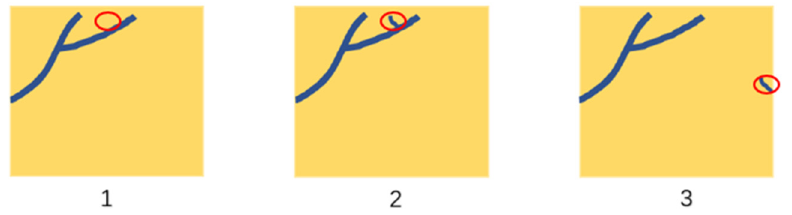
Figure 1. Three datasets of water body distribution (areas with differences are circled in red).